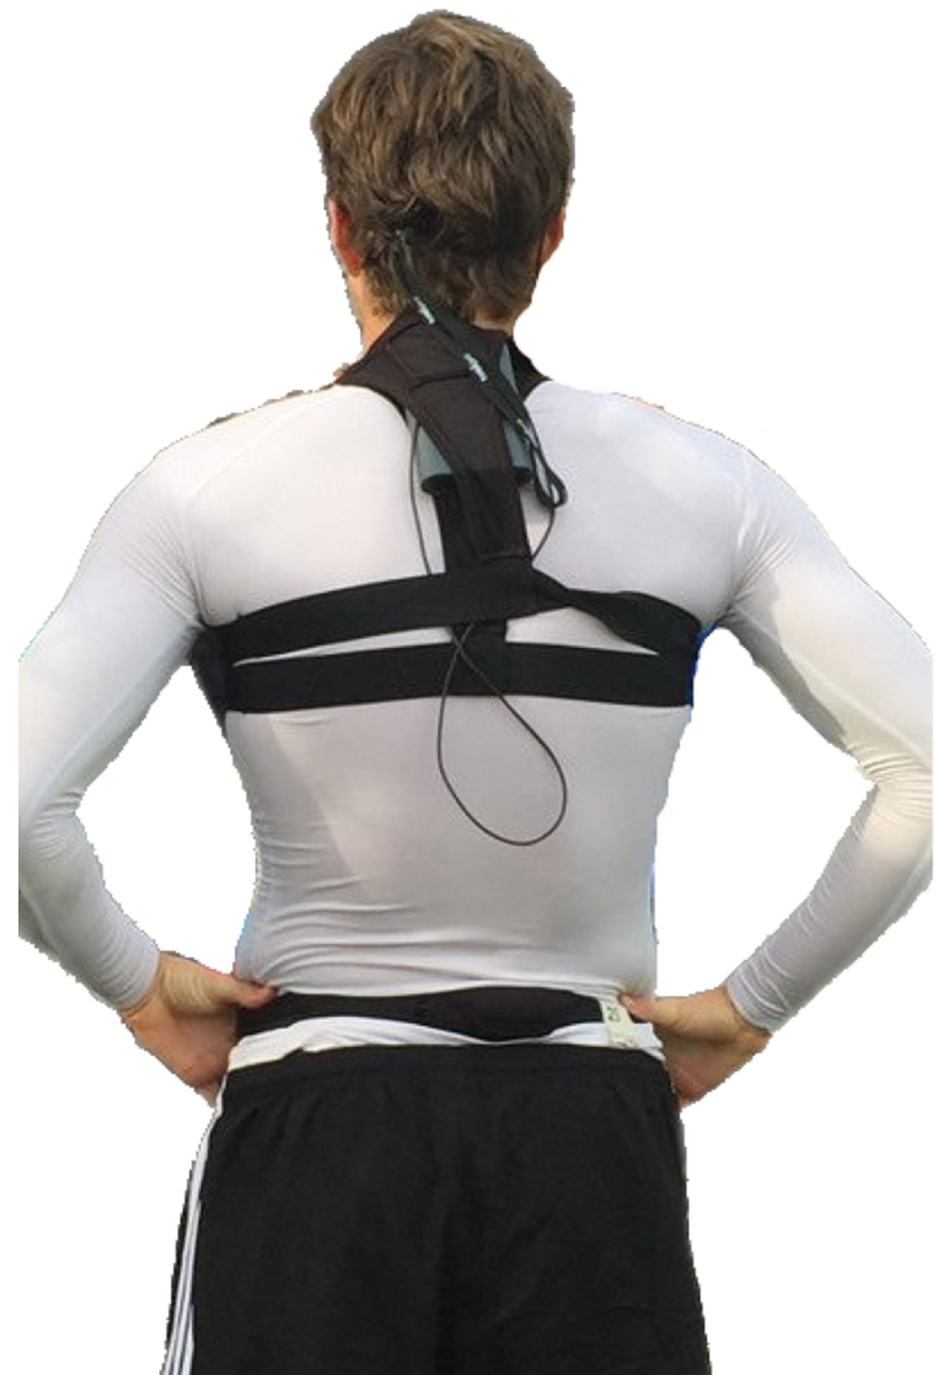
Fig 1. The Tobii Pro Glasses 2 recording unit attached on the upper back of one of the participants. Printed with permission.